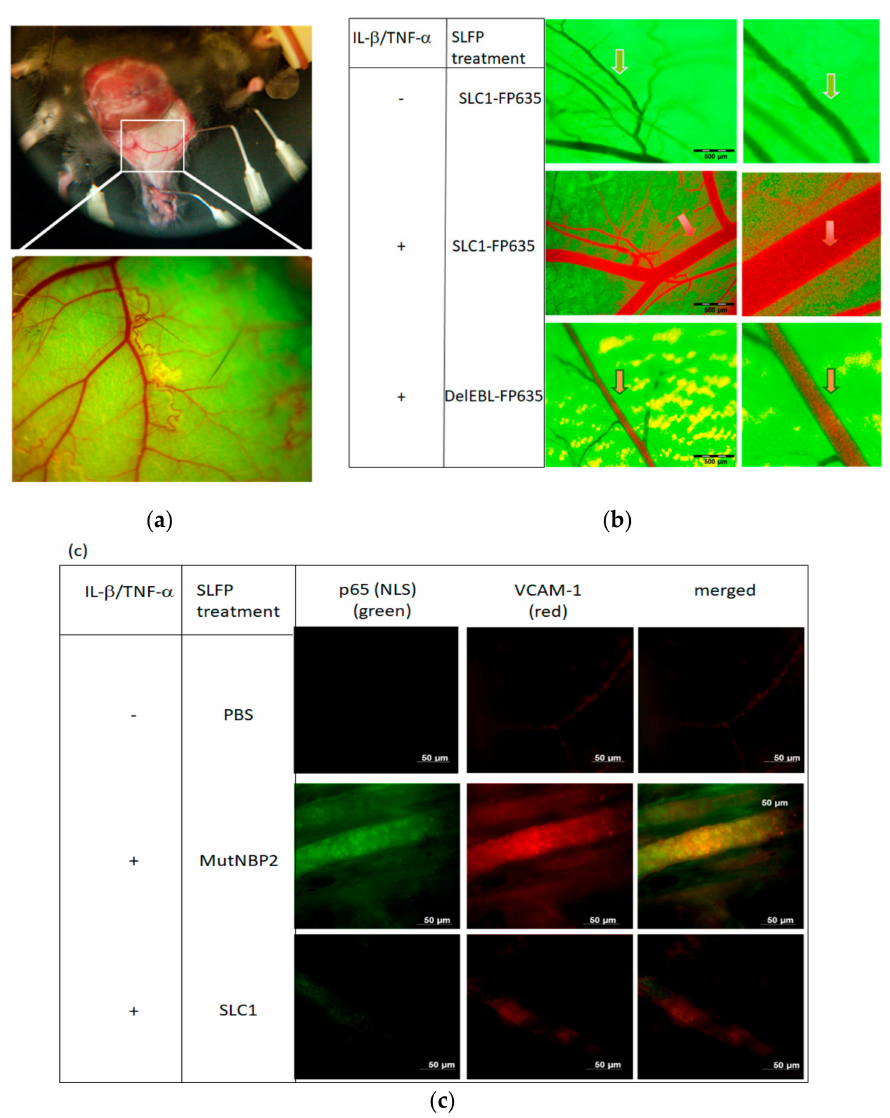
Figure 7. In vivo imaging to visualize SLC1 binding and inhibition of NF-kappaB activation. ( a ) Skin flap preparation of GFP expressing transgenic mice under anaesthesia. In vivo images of the vasculature in a selected area of the tissue are depicted at di ff erent magnifications ranging from × 1.6 to × 16 and a field of view ranging from 6.9 to 0.69 mm. ( b ) Visualization of vessels in a non-activated state (upper row) exhibits the GFP-background fluorescence but no staining by the systemically administered red-fluorescent SLC1-FP635. Mice receiving a local cytokine-challenge (lL-1 β / TNF- α ) showed an intense orange staining (arrow) of the vascular endothelium (middle row) after systemic SLC1-FP635 treatment, whereas in DelEBL treated mice only a green fluorescence of the endothelial border is present (lower row). ( c ) Whole-mount immunofluorescence stainings of cytokine-activated mouse skin. Mice were treated intraperitoneally (i.p.) with PBS, MutNBP2 or SLC1. Whole mount was stained with an anti-NF-kappaB-(NLS) p65 antibody (green) detecting nuclear p65 and an anti-VCAM-1 antibody (red). NLS-p65 exposure and VCAM-1 expression is not detectable in unactivated (-IL-1 β / TNF- α ) PBS-treated mice (upper row). NLS-p65 and VCAM-1 is detectable in activated ( + IL-1 β /+ TNF- α ) mice treated with the control MutNBP2 (middle row). SLC1 treatment suppresses NF-kappa activation in activated mice. Here the NLS-p65 region is not detectable accompanied by reduced endothelial VCAM-1 expression (lower row) (Figures from [23], kindly provided by